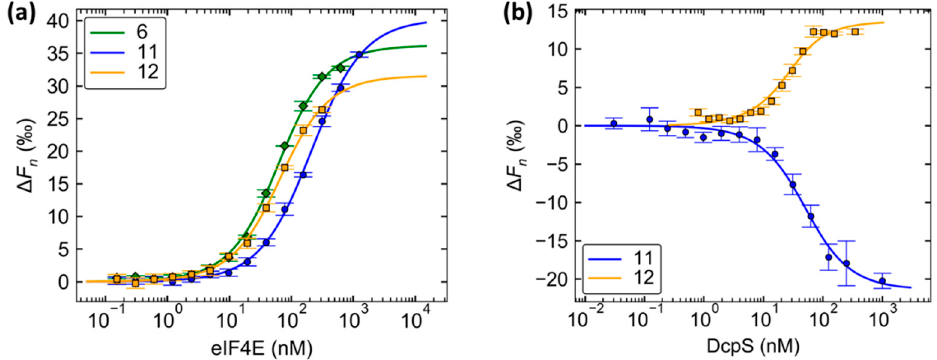
Figure 5. Direct binding microscale thermophoresis (MST) experiments with eIF4E and DcpS. ( a ) MST binding curves for probes 6, 11 , 12, and meIF4E. Probe 6 , 11 , or 12 (50 nM) was mixed with a half-log dilution series of an meIF4E solution (10 µM–0.30 nM). ( b ) MST binding curves for probes 11 and 12 and DcpS. A solution of probe 11 or 12 (50 nM) was mixed with a dilution series of hDcpS solution (2.0 µM–0.061 nM for 11; 700–1.6 nM for 12 ). MST traces for each experiment are shown in Figures S5 and S6. Data were analyzed in Palmist v. 1.4.4 using 1:1 binding model. The K D values were calculated from triplicate experiments and are shown in Table 2. Table 2. K D values of the binding a ffi nities for murine eIF4E and human DcpS determined by MST. K D values were calculated from triplicate